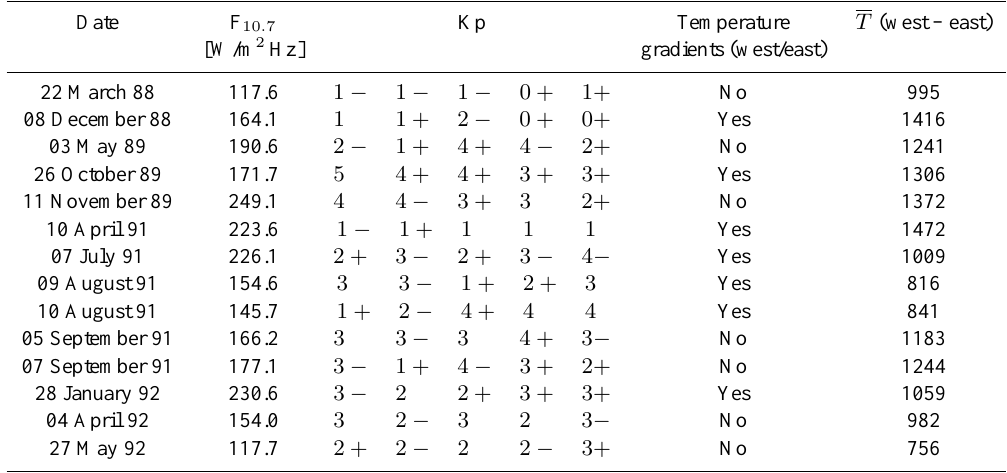
Table 1. A list of observation dates, solar-geomagnetic conditions temperature gradients and mean nocturnal temperature, considered in this